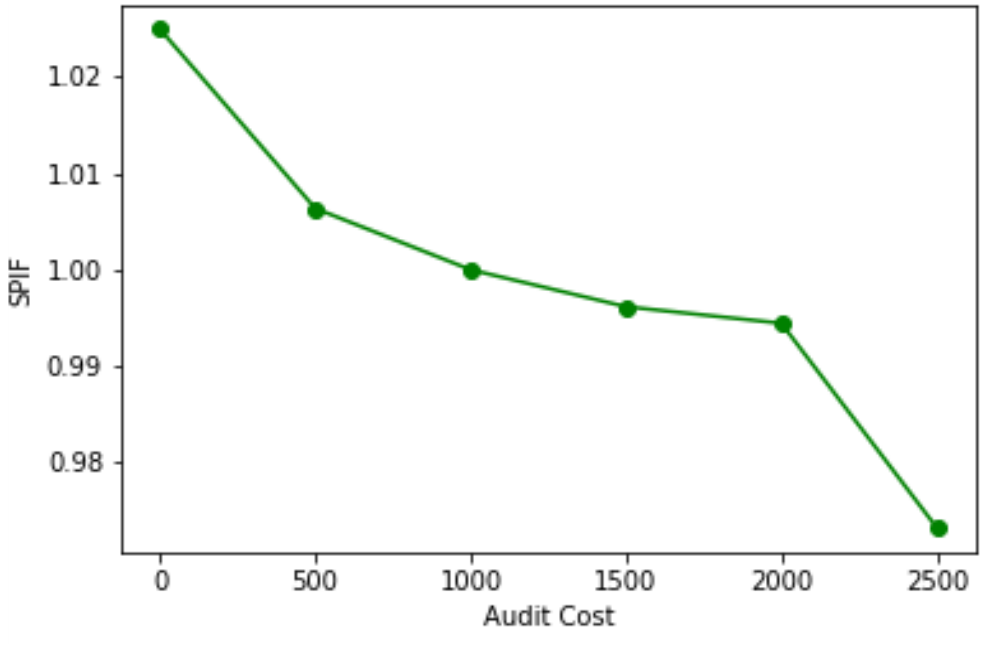
Figure 6. Effect of audit cost on